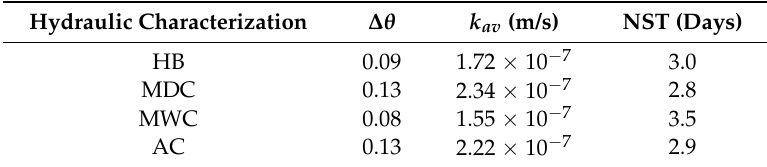
Table 3. Dominant factors ( k av = average hydraulic conductivity; ∆ θ = overall water content) and NST (null suction time) in case B: HB (hysteretic behavior), MDC (main drying curve), MWC (main wetting curve), and AC (average